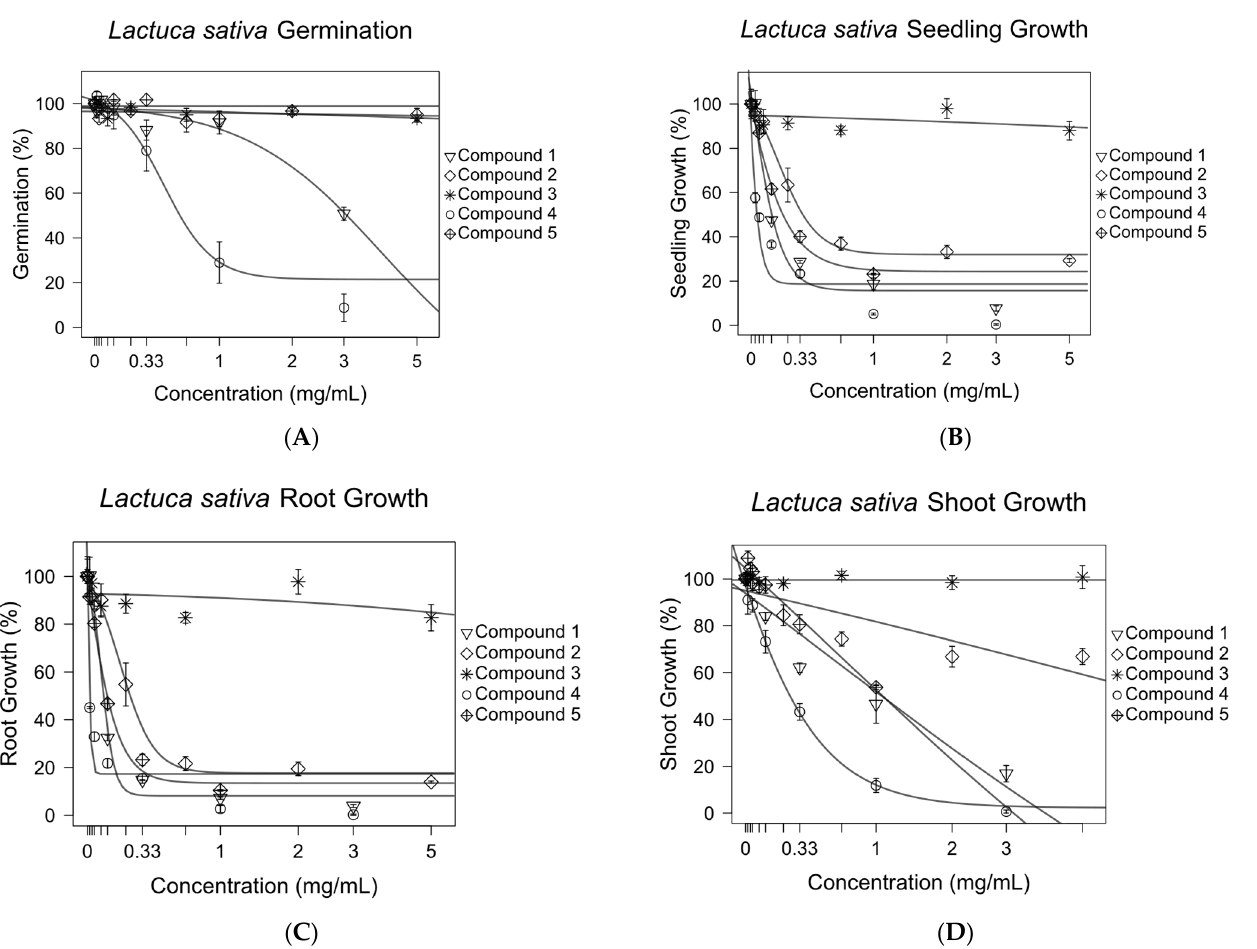
Figure 6. Inhibitory effects of purified antileukemic compounds on the germination ( A ) and growth of the Lactuca sativa seedlings ( B ), roots ( C ), and shoots ( D ). Sigmoidal concentration–response models were used to calculate the growth inhibition at 50% (GI 50 ) for compounds 1–5 against L. sativa root, shoot, and seedling growth. The optim function in R was used to fit nonlinear regression curves. Error bars are ±SEM.